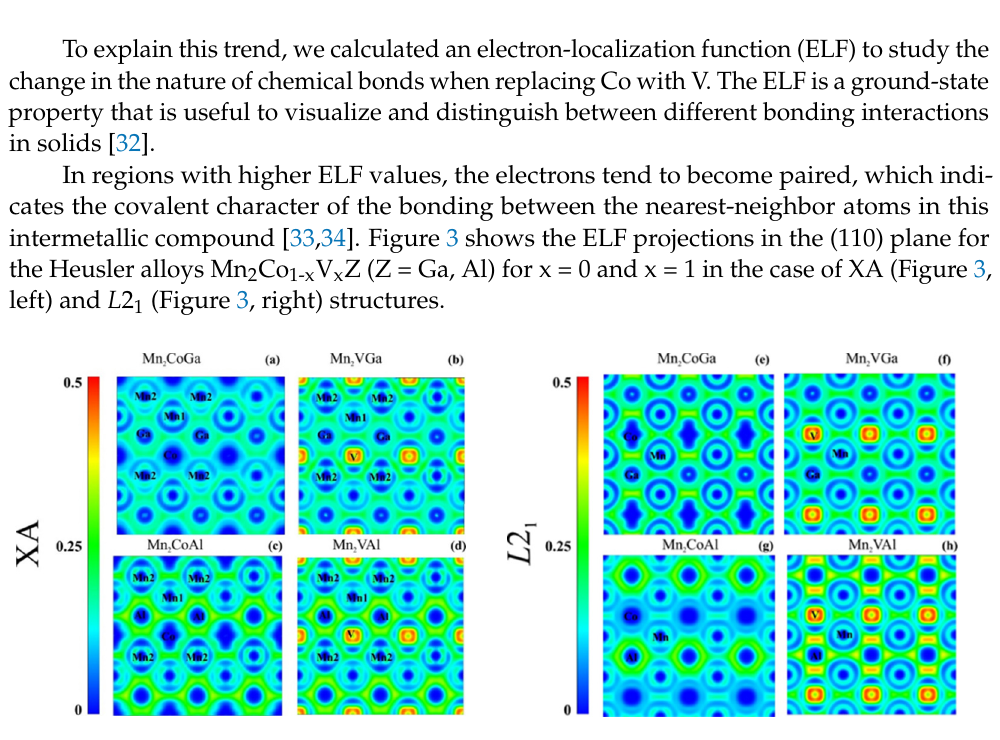
Table 1. Energies of crystal formation.